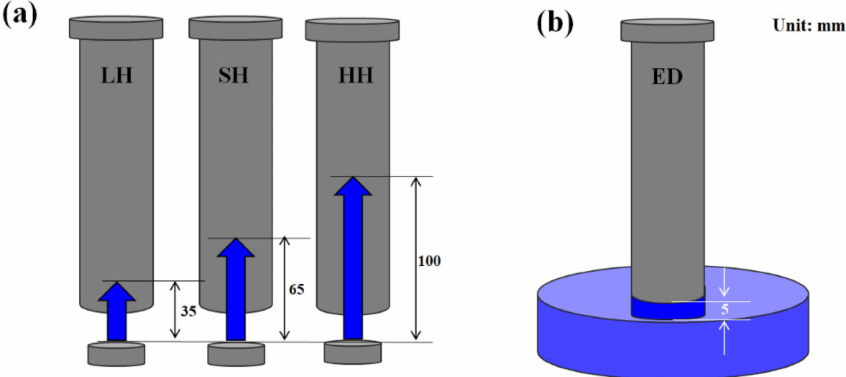
Figure 2. Schematics of the cooling conditions in this study: ( a ) the influence of water jet height and ( b ) the influence of end dipping cooling process. Table 1. Chemical composition (weight percent) of the steels used in the present study.